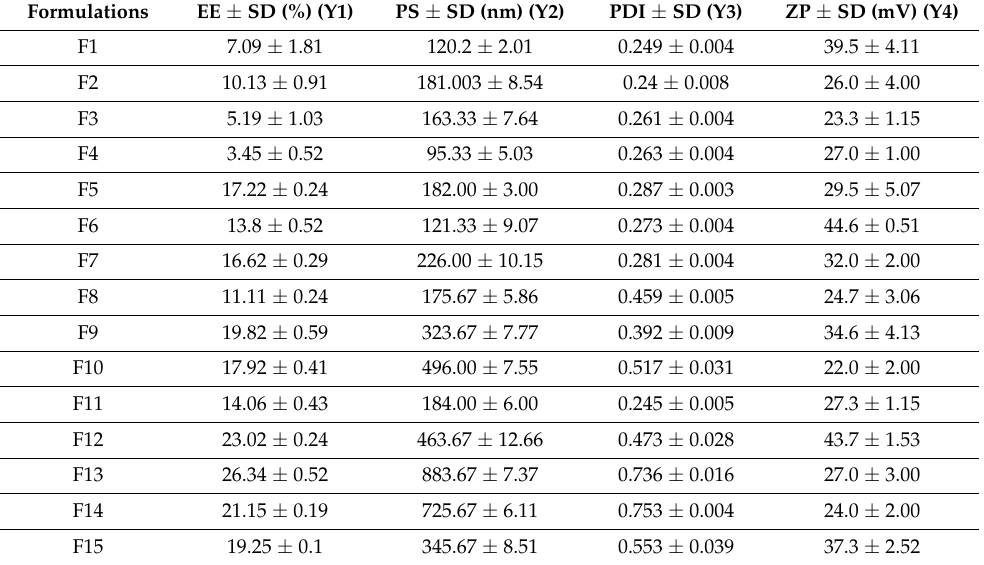
Table 3. Responses on encapsulation efficiency percent (EE%), particle size (PS), polydispersity index (PDI), and zeta potential (ZP) of the generated formulations.